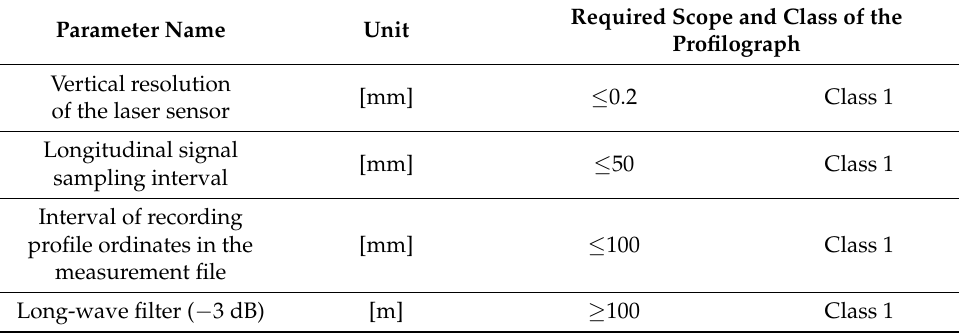
Figure 9. Laser profilograph used to measure the longitudinal evenness of the tested road section. Table 2. Parameters for a laser profilograph to measure longitudinal evenness.